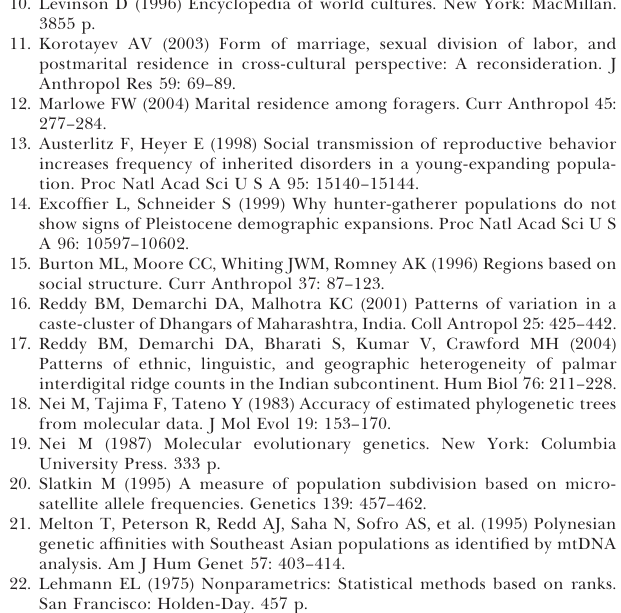
Table S1. Y-Chromosome Haplotypes Based on Six Y-STRs for 15 Populations Found at DOI: 10.1371/journal.pgen.0020053.st001 (946 KB DOC). Table S2. Y-Chromosome Haplotypes Based on Nine Y-STRs for Six Populations Found at DOI: 10.1371/journal.pgen.0020053.st002 (387 KB